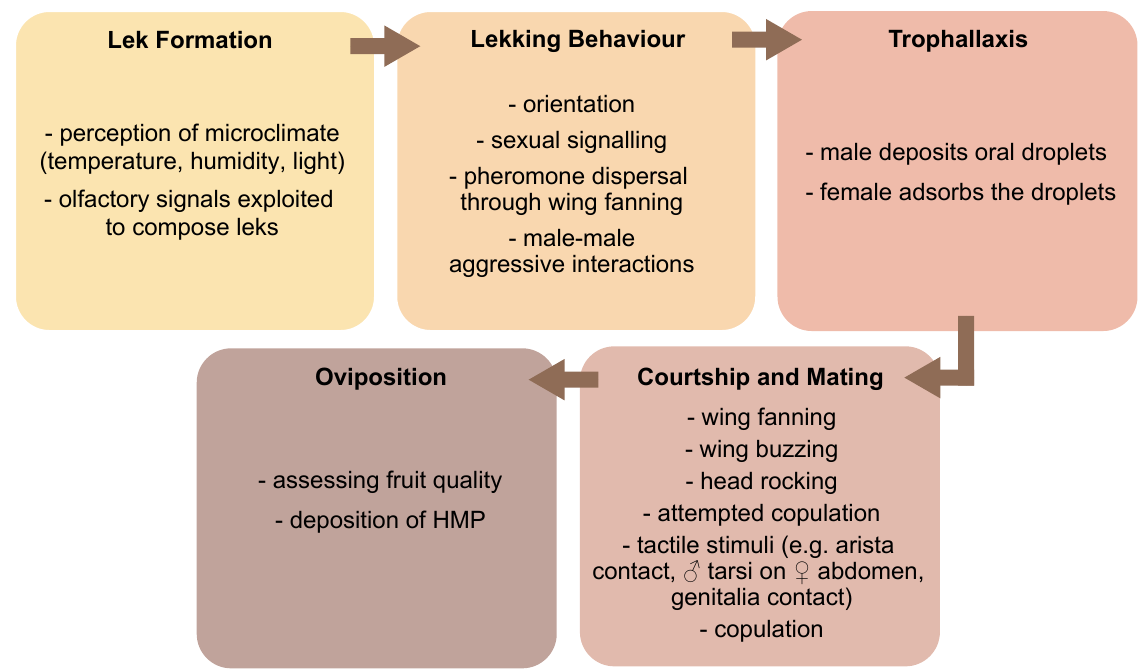
Figure 2. Diagram showing the main steps of mating behaviour in tephritids and the signals transmitted and perceived. Lekking behaviour is common in Tephritidae, but notably absent in Rhagoletis species. Similarly, pre-mating trophallaxis is common, but this phenomenon is known to occur also during and post mating [47]. HMP, host-marking